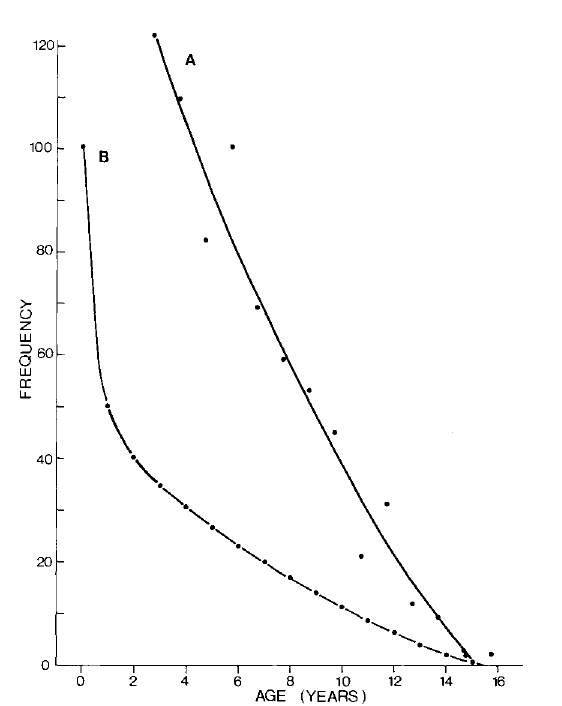
Figure 1. Survivorship curves for female barren- ground caribou 3 years old (A), based on pooled age distributions in samples from the Beverly herd, obtained from 1980 through 1987, and for all ages (B) where assumptions are made concerning survival from birth to 3 years (see